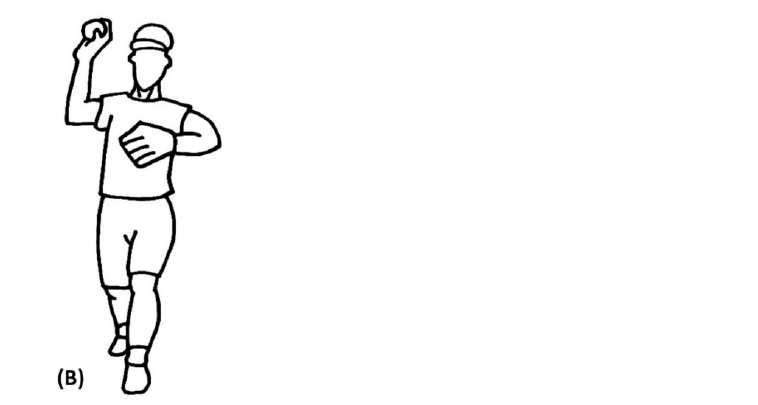
Figure 1. ( A ) Closed pattern of “hip-to-shoulder separation”; ( B ) Open pattern of “hip-to-shoulder separation”. Table 1. Demographics of two groups.